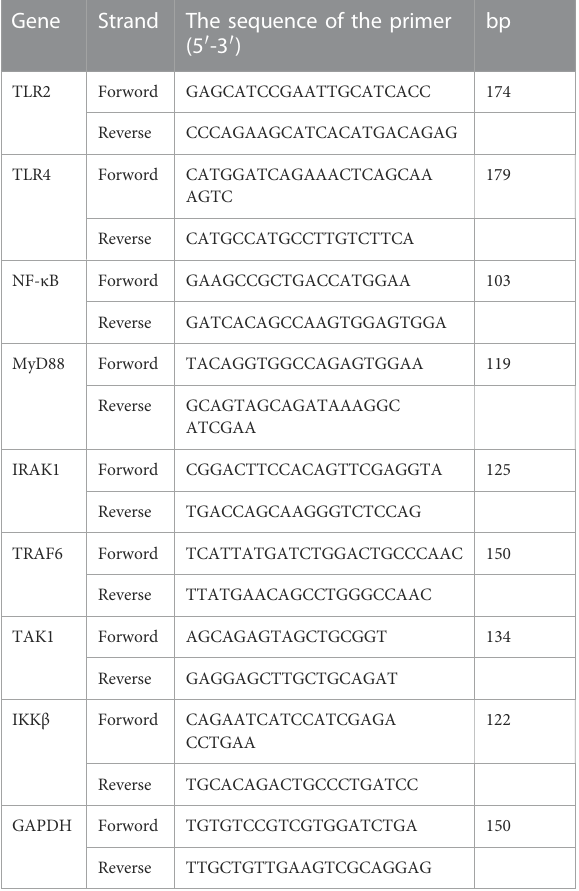
TABLE 1 Sequences of primers used for